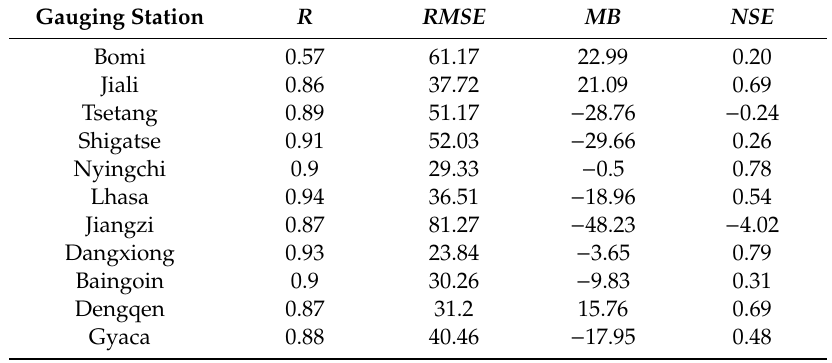
Table 2. Statistical indicators of precipitation between the GLDAS-NOAH and gauging